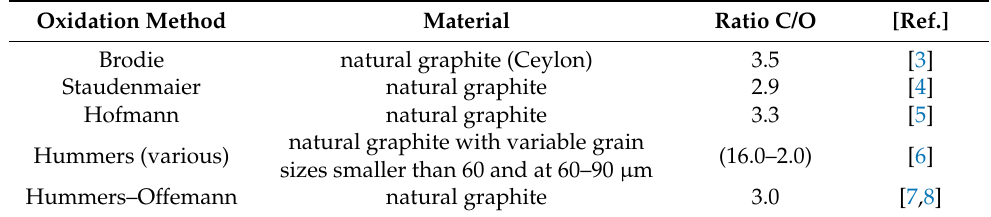
Table 1. The influence of the oxidation method on the oxygen content in the GO. Oxidation